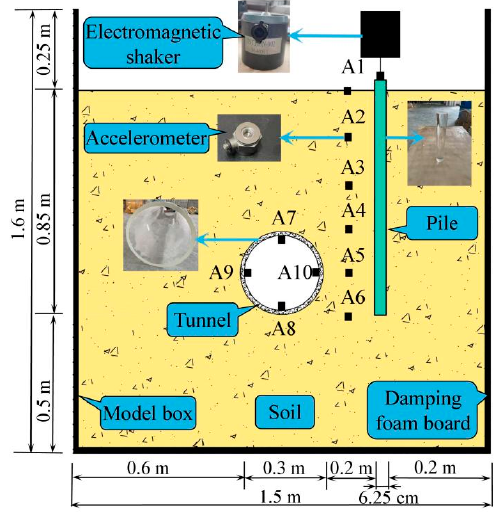
Figure 3. Schematic layout of monitoring points.